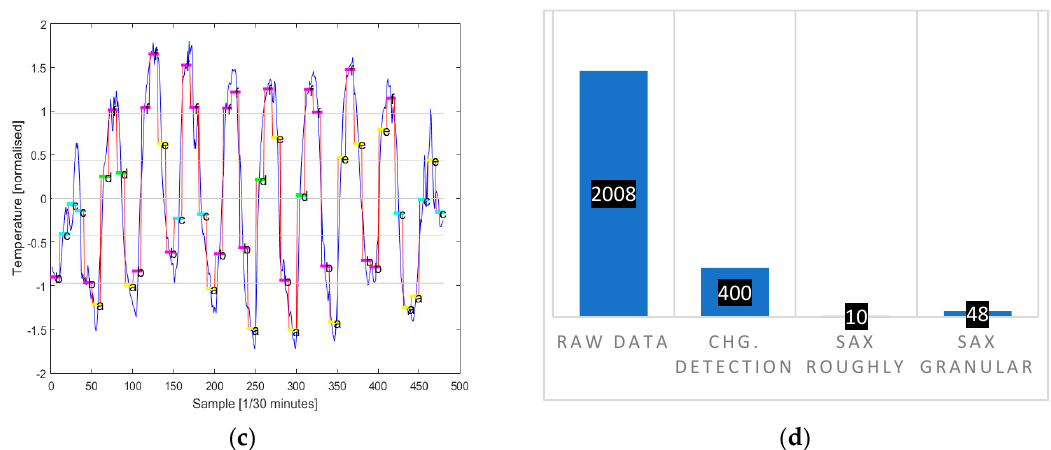
Figure 19. Relevant data extraction: ( a ) change detection method; ( b ) SAX algorithm–Roughly; ( c ) SAX algorithm–Granular; and ( d ) comparative representation of data sizes achieved using the proposed relevant data extraction methods.